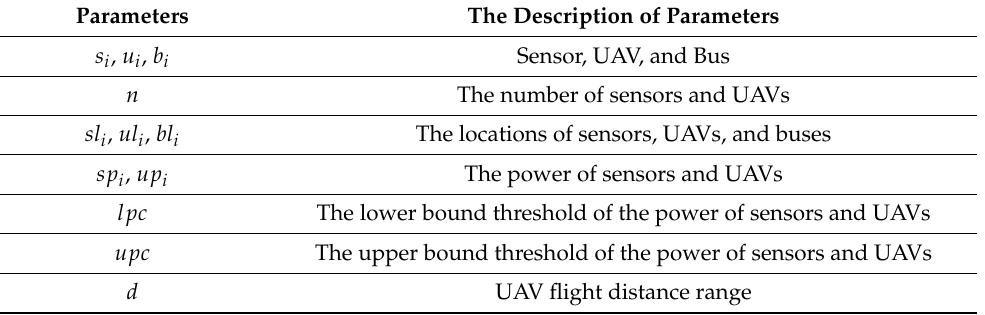
Table 2. Symbols used in this